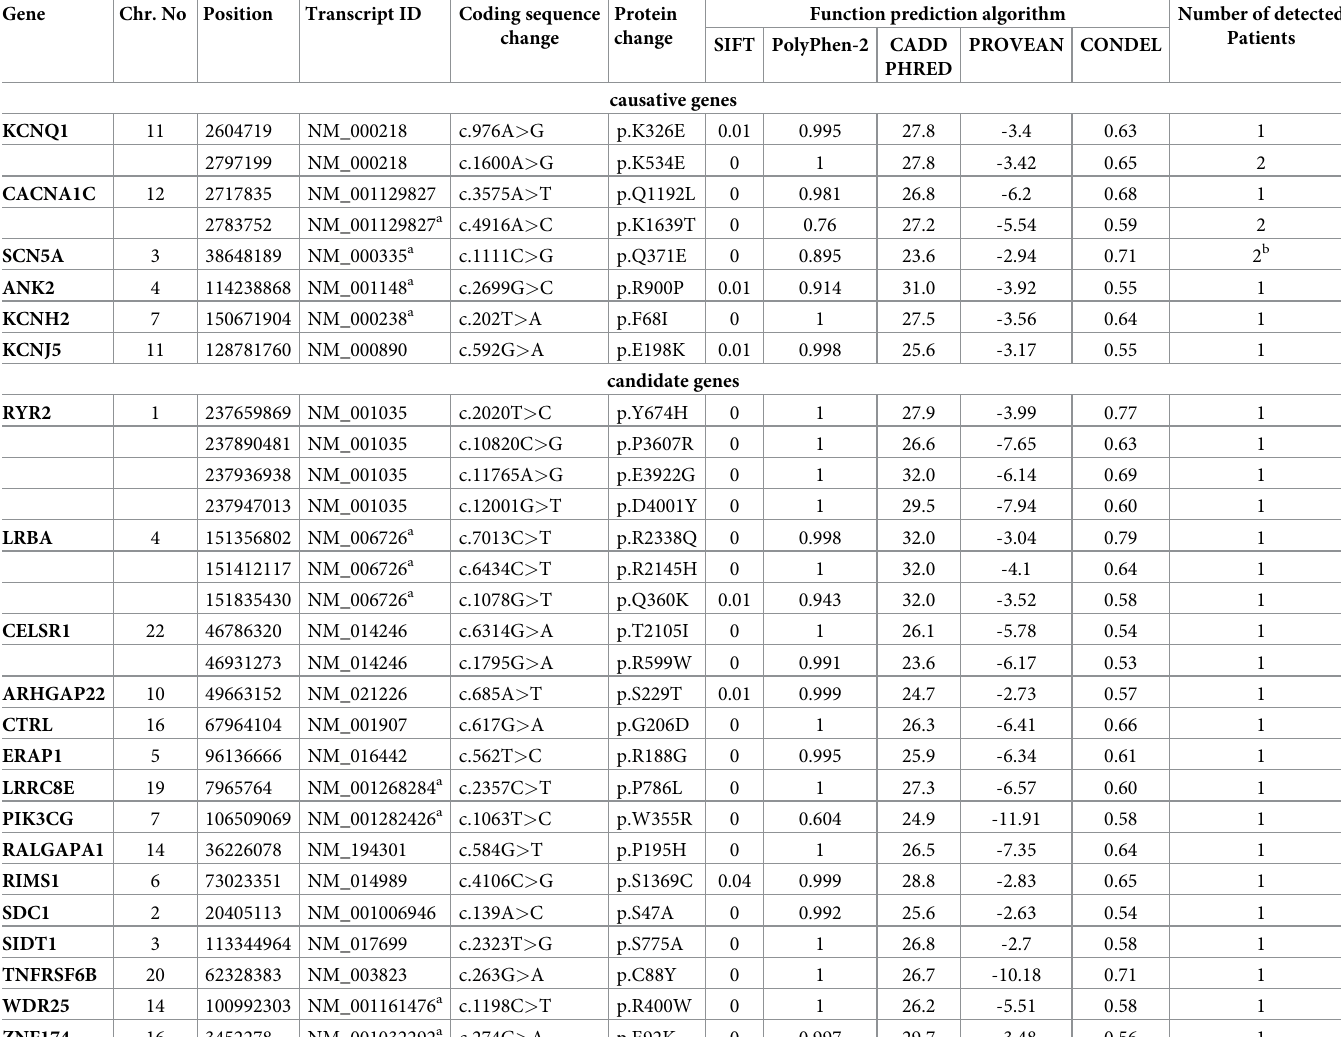
Table 3. Characteristics of newly detected variants and their functional prediction scores. Gene Chr. No